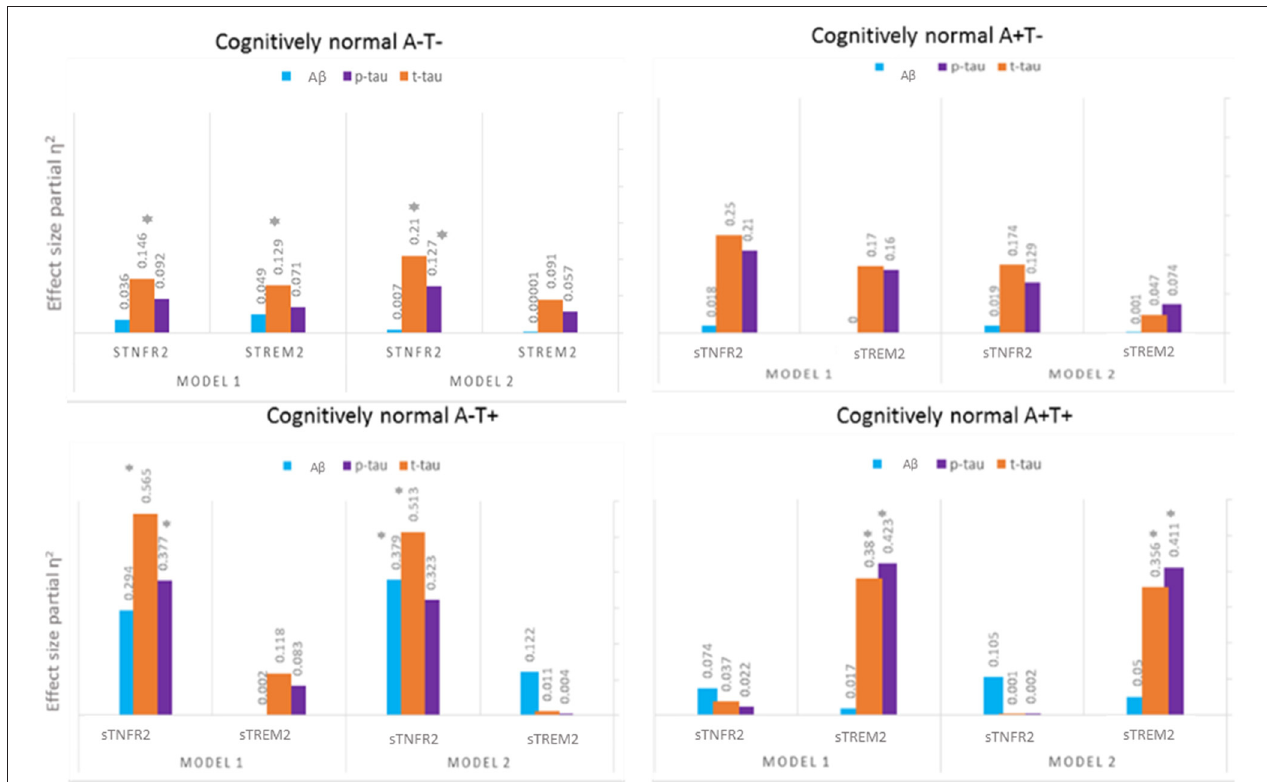
FIGURE 3 | Effect sizes for baseline CSF sTREM2 and TNFR2 in linear models predicting baseline CSF t-tau, p-tau, and A β 42 among A– T–, A– T + , A + T–, and A + T + cognitively normal participants. * P ≤